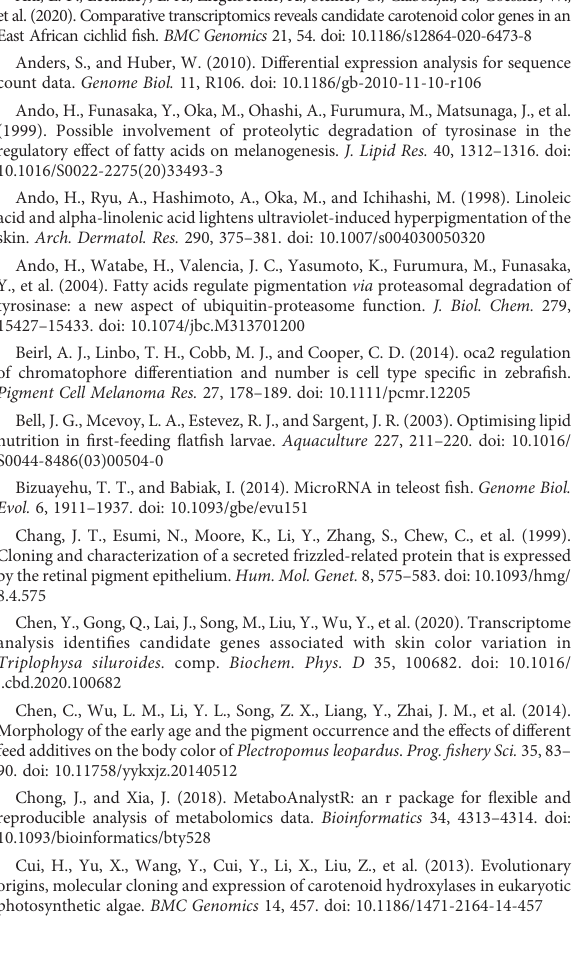
SUPPLEMENTARY FIGURE 2 Transcriptome analysis of brown- and red- colored groups of leopard coral grouper Plectropomus leopardus (A) DEGs of the brown-colored and red-colored groups; (B) GO terms analysis of DEGs; (C) pathway